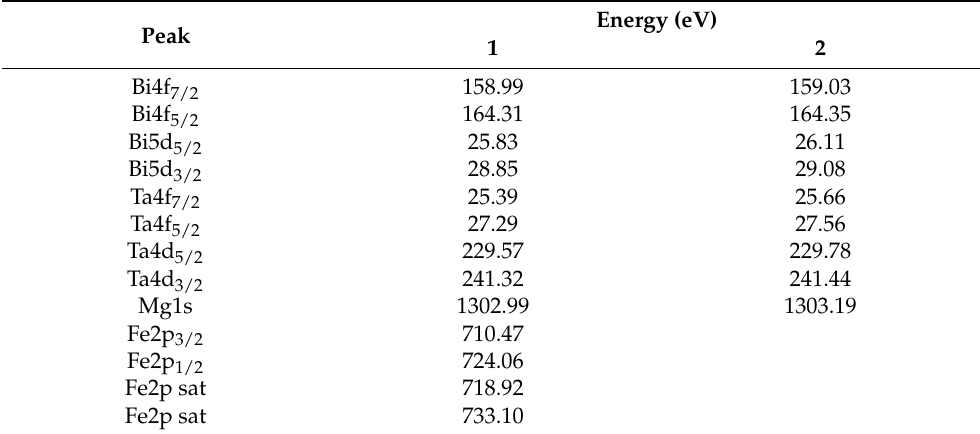
Energy positions of the components of the XPS spectra of Bi 2 MgTa 2 O 9 (1) and Bi 2 Mg 0.5 Fe 0.5 Ta 2 O 9.5 − ∆